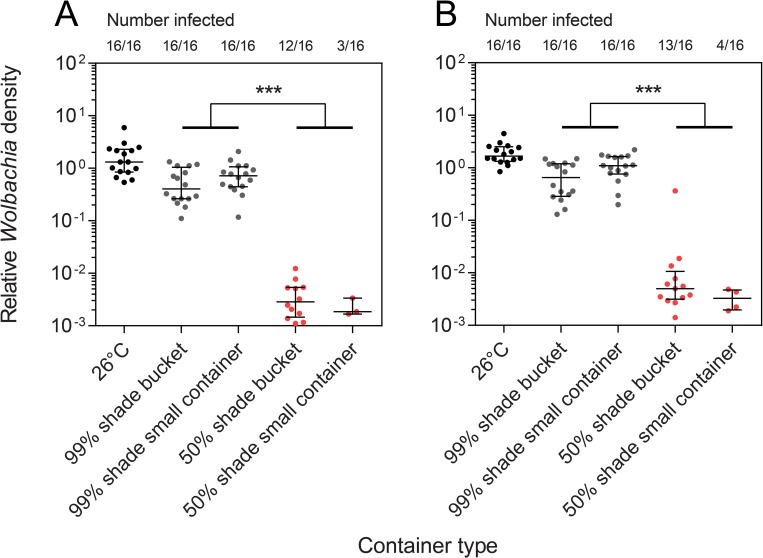
Wolbachia density of (A) Females and (B) males reared in different container types at two levels of shade in the second field experiment. The number of mosquitoes from each treatment that were positive for Wolbachia is also shown. All error bars are medians with interquartile ranges. *** P < 0.001 by Kruskal-Wallis test.